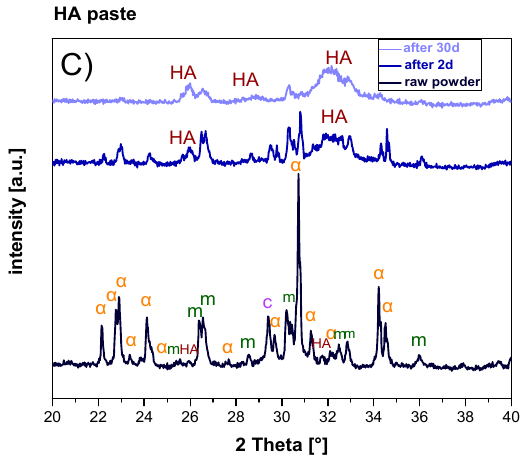
Figure 1. X-ray diffraction patterns of the raw powders as well as premixed cement pastes derived from Ca 0.25 Mg 2.75 (PO 4 ) 2 ( A ) and Ca 0.75 Mg 2.25 (PO 4 ) 2 ( B ) and the HA forming reference cement ( C ) after 2 and 30 d immersion in PBS buffer. Peaks are labelled with: α : α -TCP, m: monetite, c: calcite, HA: hydroxyapatite, f: farringtonite, s: stanfieldite, str: struvite, and n: newberyite.